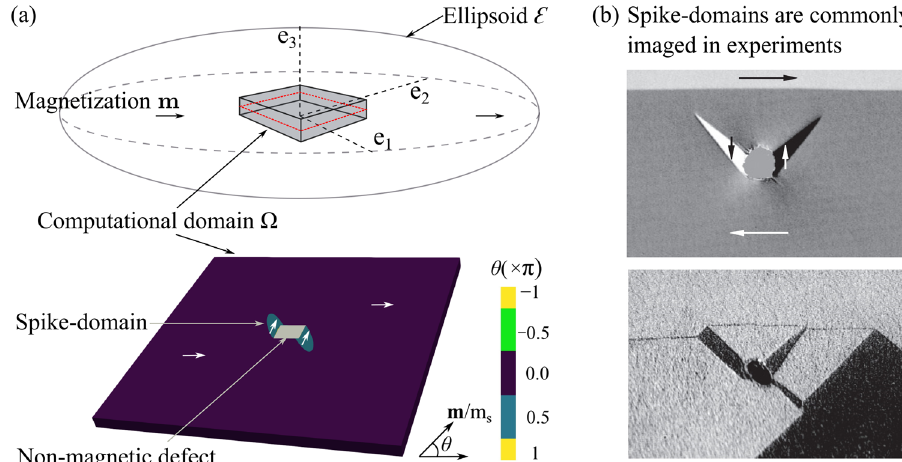
Fig. 1 We model a 3D computational domain with a spike-domain microstructure. a The 3D computational domain is Ω embedded inside an oblate ellipsoid E , which is several times larger in size than Ω . A spike-domain microstructure forms around a nonmagnetic defect that grows under an applied fi eld. (b) Spike-domain microstructures are commonly found in magnetic materials around defects such as cavities and pores in Fe fi lm and Fe – Si crystal, respectively 21,40 . (Reprinted sub fi gure ( b ) with permission from ref. 40 . Copyright (2020) by the American Physical